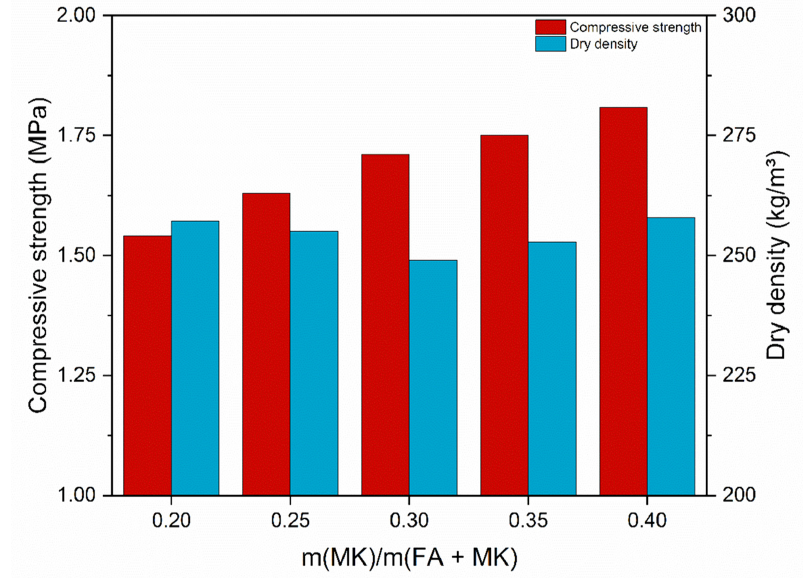
Figure 10. Influence of the metakaolin / fly ash ratio on dry density and compressive strength according to Reference [73].